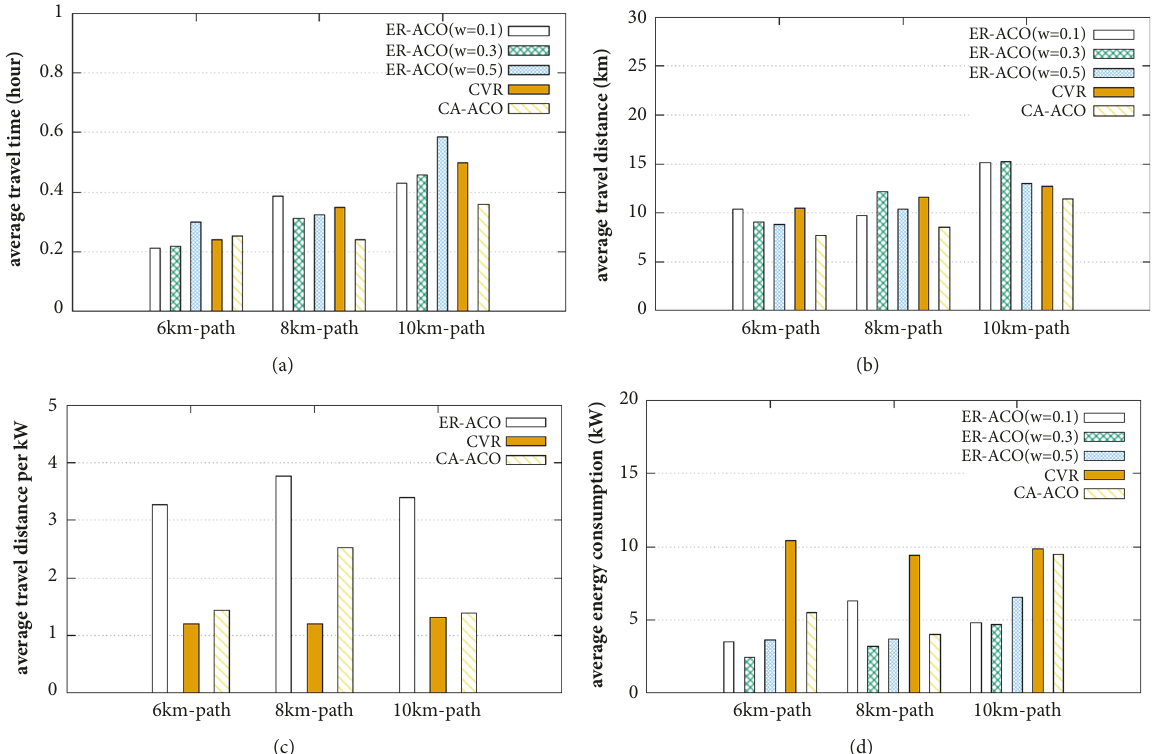
Figure 7: Performance comparison with a varying distance between the source and destination in a uniform distribution: (a) travel time, (b) travel distance, (c) travel distance per energy consumption, and (d) energy